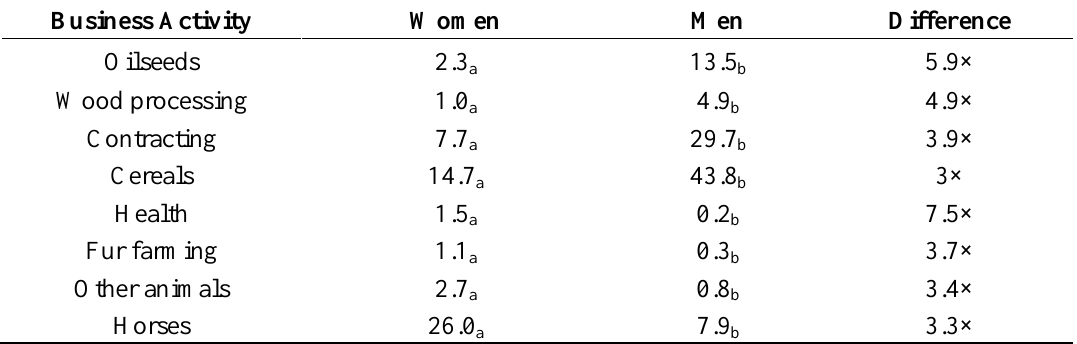
Note: Values within rows and table parts with different subscripts are significantly different ( p < 0.05) in the two-sided test of equality for column proportions. Cells with no subscript were not included in the test. Tests assumed equal